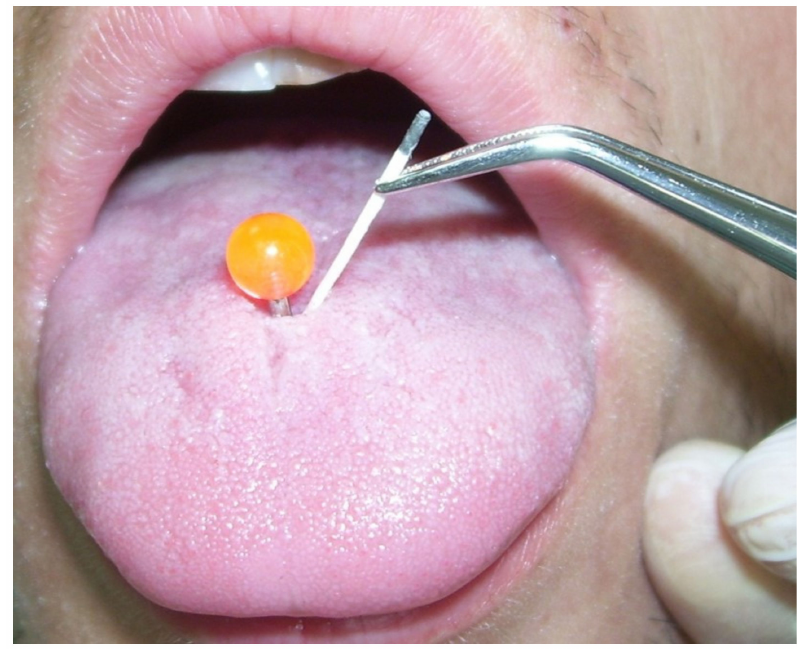
Figure 2. A sampling of the tongue piercing